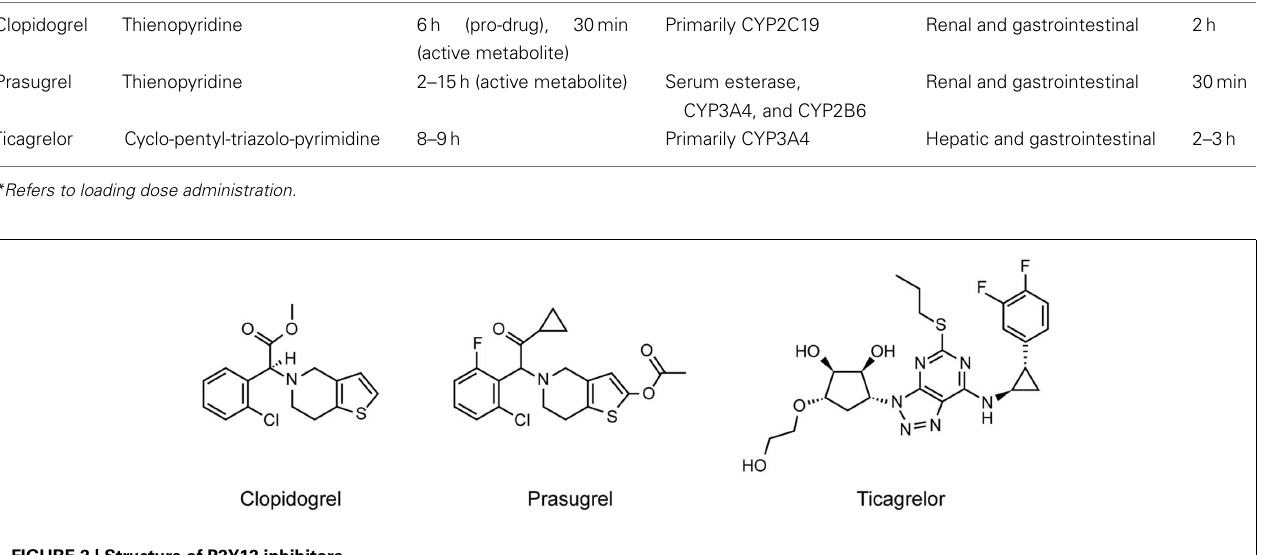
FIGURE 2 | Structure of P2Y12